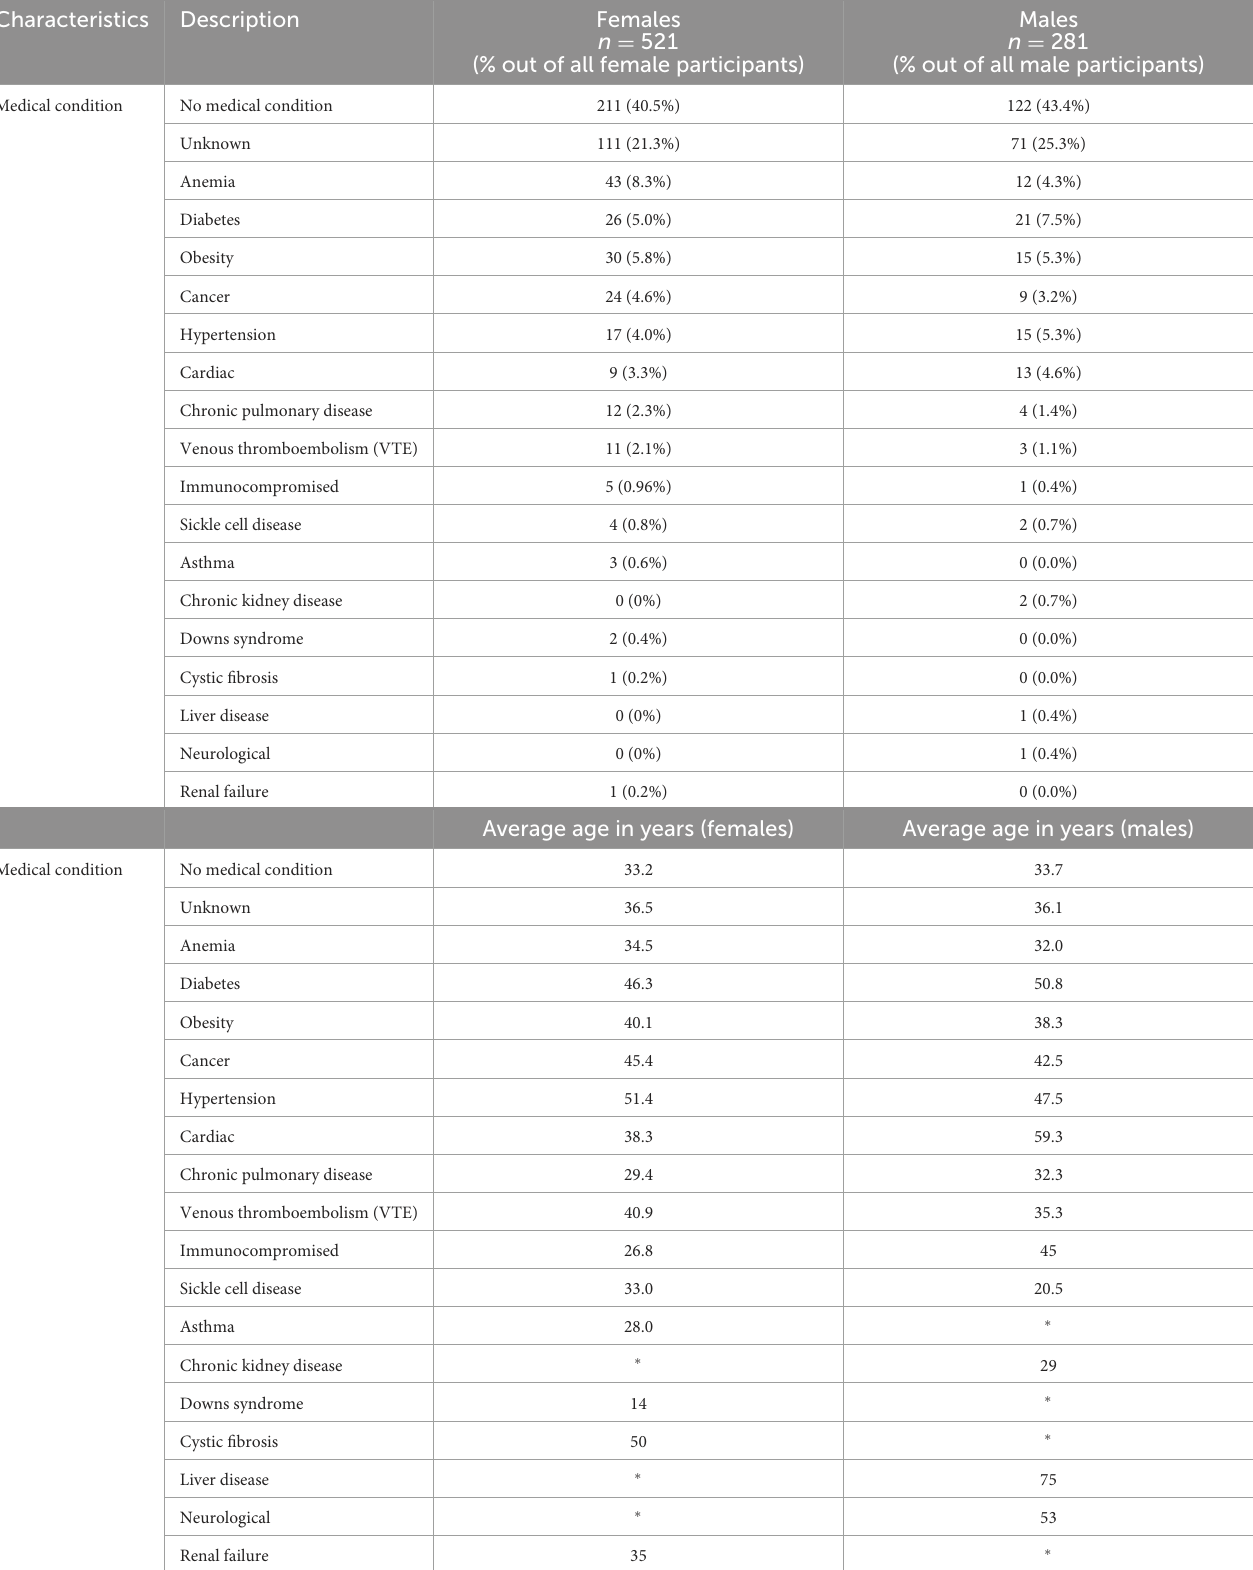
TABLE 2 Study participants’ medical conditions categorized by gender and age.